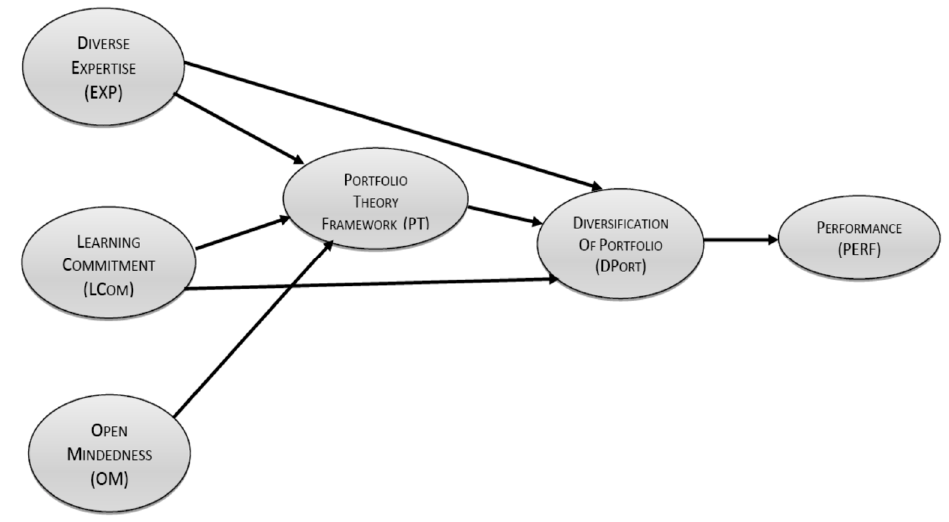
Figure 1. Conceptual Model 1.